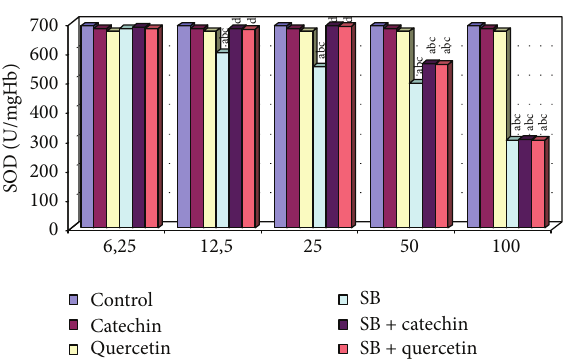
Figure 5: GST activity in erytrocytes of control and experimental groups. Different letters above the bars indicate significant differ- ences between exposure concentrations; bars with the same letter are not significantly different. Values are mean ± SD in each group. Significance at 𝑃 < 0.05